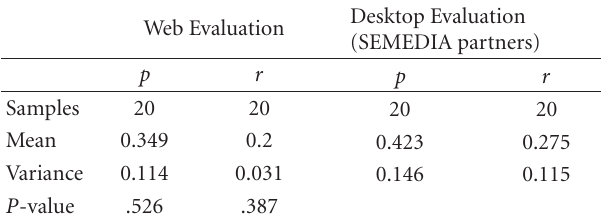
Table 5: Results of the comparison of precision ( p ) and recall ( r ) of the Web-based application and the desktop application using a two- tailed two-sample t -test assuming di ff erent variances, significance level 0.05.